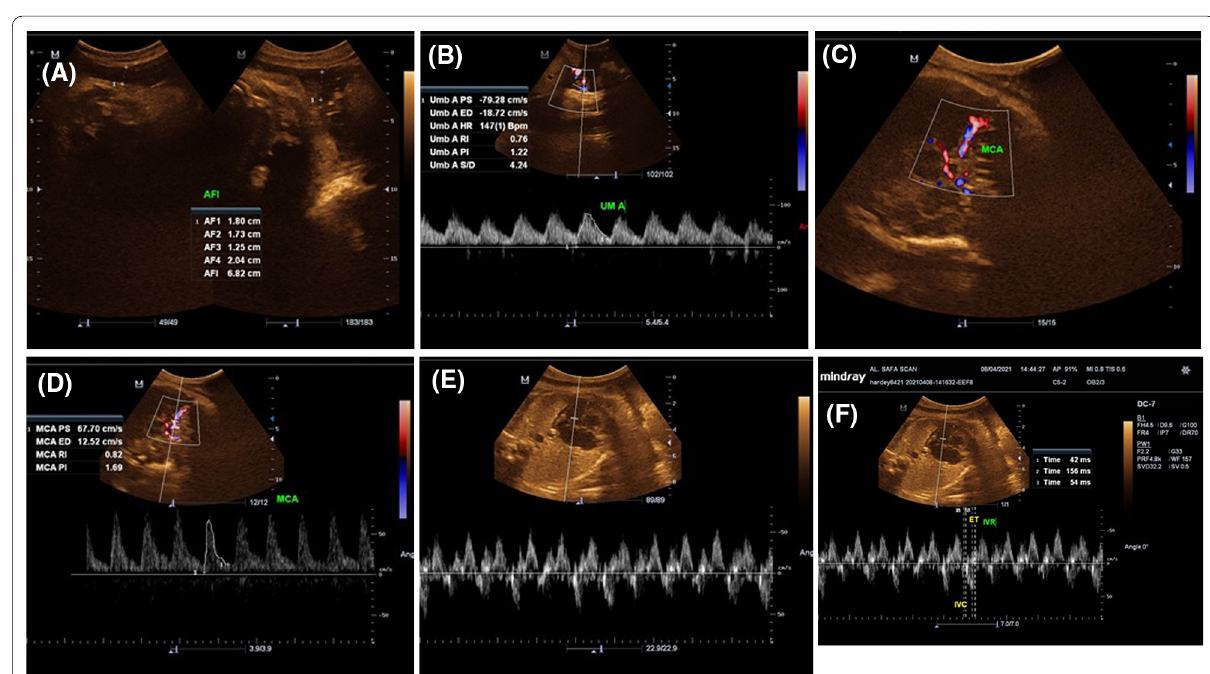
based on echoes from the opening and closure of the mitral and aortic valves with a calculated MPI